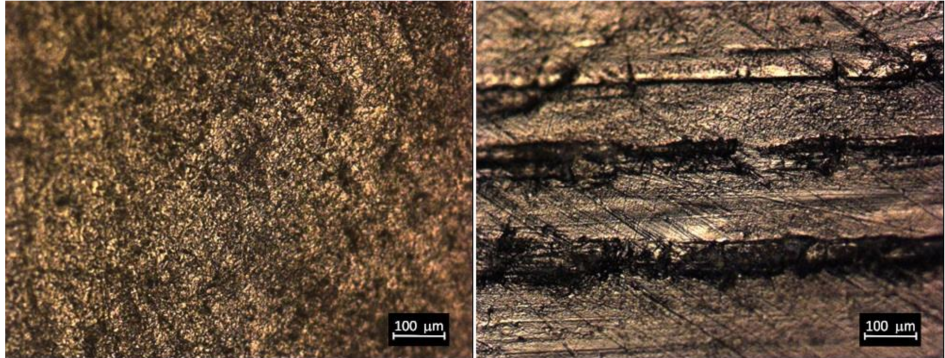
Figure 4. Micrographs of UHMWPE surface before ( left ) and after ( right ) the test (zoom 10X).